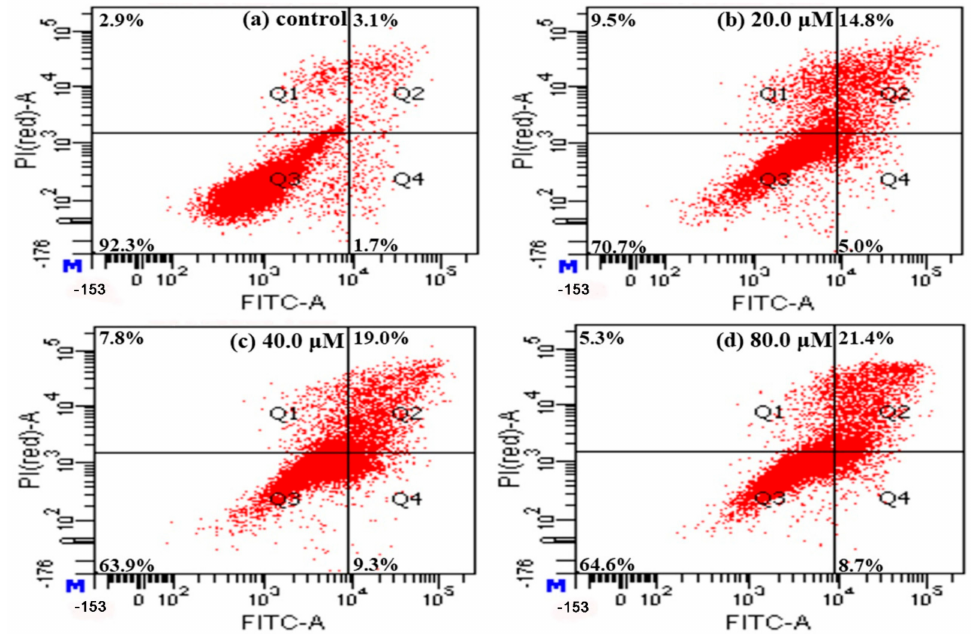
Figure 7. Flow cytometry analysis for apoptosis of HepG2 (none expression of PSMA) cells induced by CPT-HT-J-ZL 12 : ( a ) control group; ( b ) 20.0 µ M; ( c ) 40.0 µ M; and ( d ) 80.0 µ